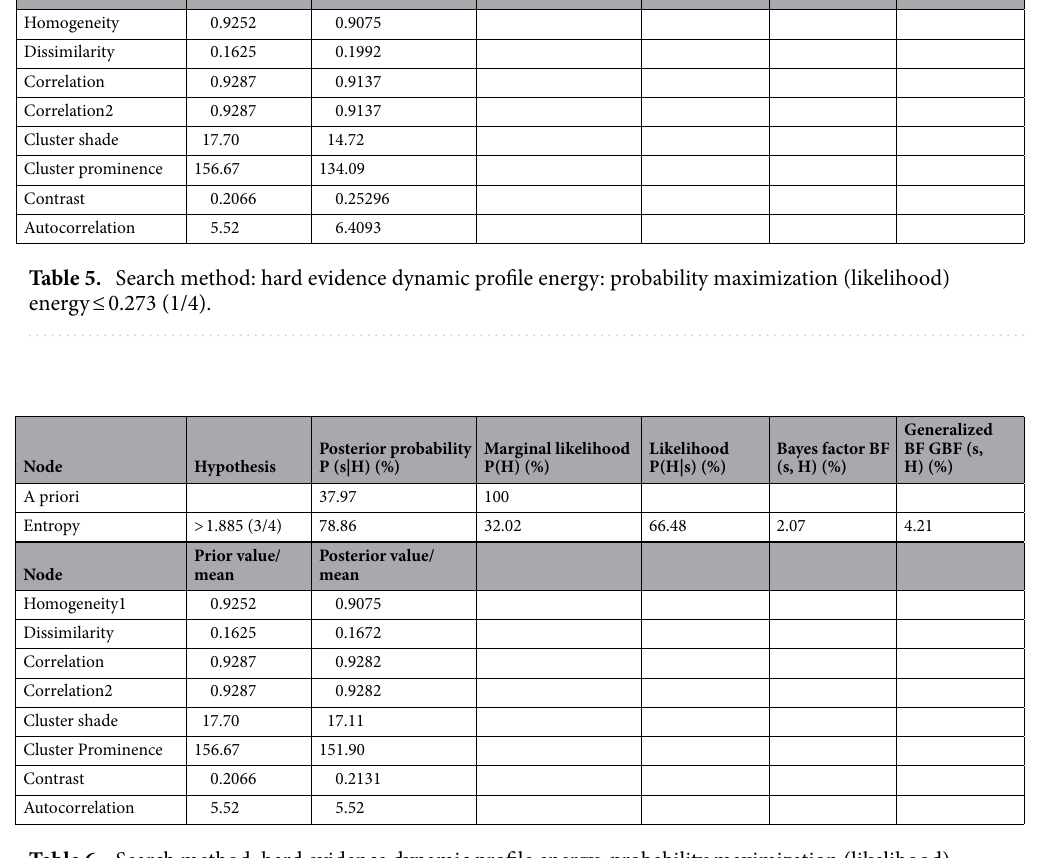
Table 6. Search method: hard evidence dynamic profile energy: probability maximization (likelihood) energy ≤ 0.368 (2/4).